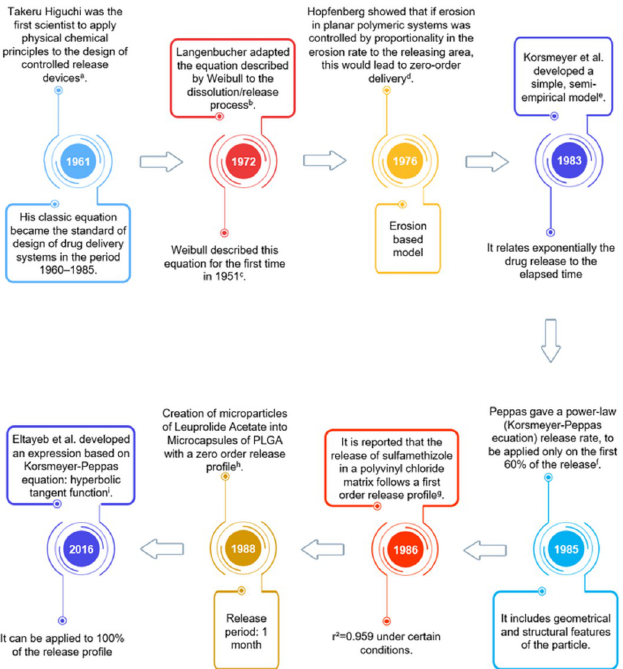
Fig 2. Time-line of conventional empirical/semi-empirical models. a. [82]; b. [83]; c. [84]; d. [85]; e. [79]; f. [81]; g. [86]; h. [50]; i.